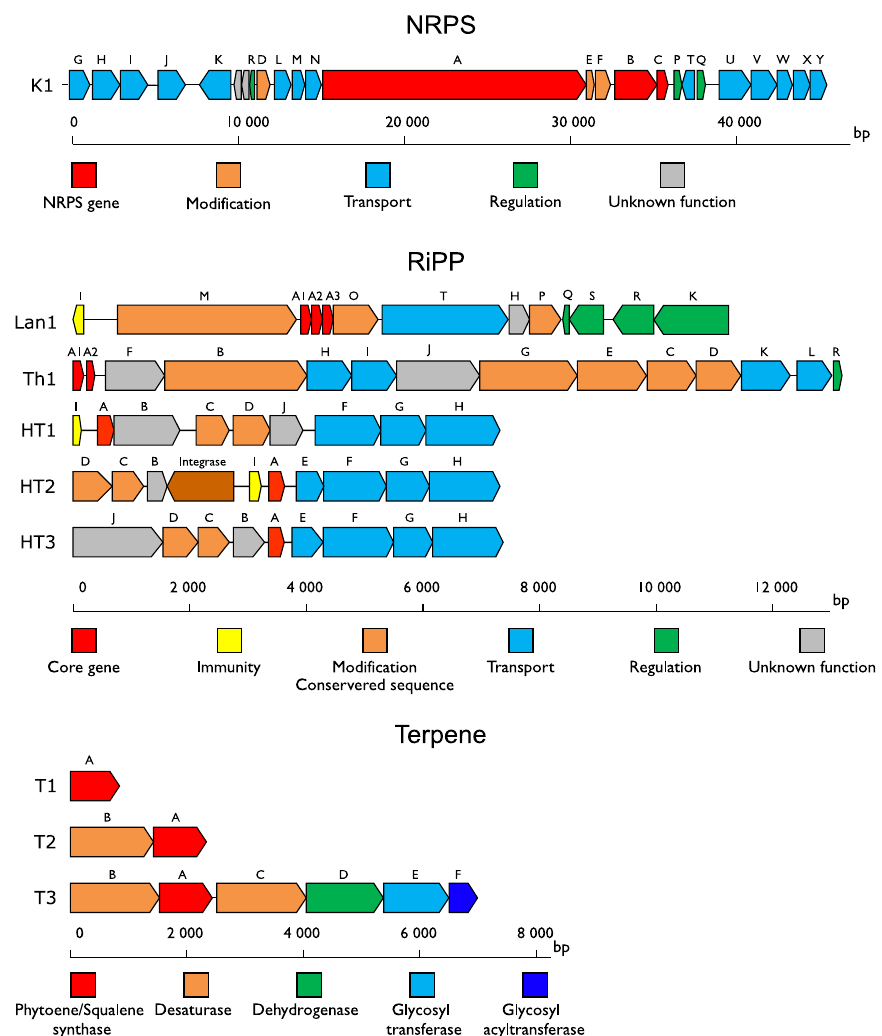
Figure 4. Undescribed biosynthetic gene cluster (BGC) structures. For each undescribed BGC, the gene length, function, and cluster organization are represented and named using letters and numbers when several core genes were predicted in the same cluster.